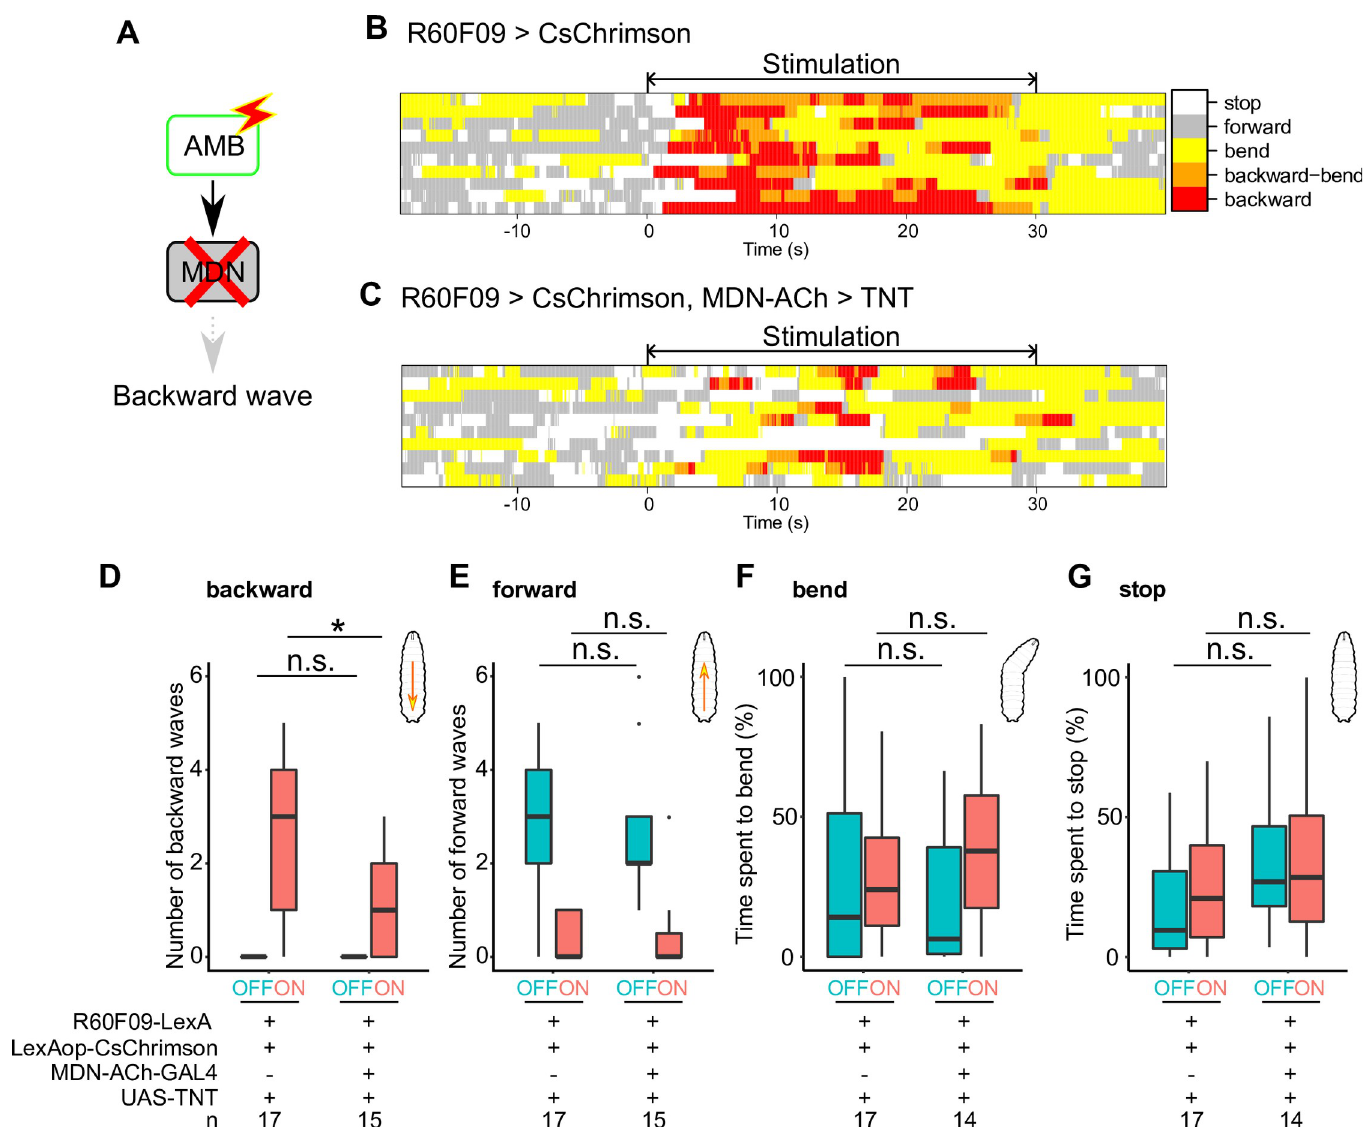
Fig 7. AMBs require MDNs to evoke backward locomotion. (A) A schematic view of optogenetic AMB activation with silencing MDNs. (B, C) Representative behavior ethograms upon optogenetic stimulation of AMB neurons. An animal expressing CsChrimson in AMBs was subjected to optogenetic activation for 30 seconds. Behavior events are color-coded: forward movement (grey), stop (white), bending (yellow), bending with backward locomotion (orange) and backward locomotion (red). Representative data from 10 different animals are shown for each genotype. (D-G) The number of backward/forward waves or percentage of time spent in a behavioral mode in 10 seconds before (OFF) and during (ON) optogenetic AMB activation with CsChrimson while silencing MDNs. In the boxplot, the width of the box represents the interquartile range. The whiskers extend to the data point which is less than 1.5 times the length of the box away from the box, and the dot represent outlier. We assessed the statistical significance by the Wilcoxon rank-sum test with the Holm method. � p < 0.05. backward responses are predominantly mediated by the gentle touch-responsive class III da (C3da) mechanosensory neurons [13]. We genetically ablated C3da neurons by expressing the pro-apoptotic genes reaper ( rpr ) and head involution defective ( hid ) [37–39] using the C3da neuron-labeling GAL4 drivers GAL4 19-12 and NompC-GAL4 [40] and found that eyelash-trig- gered backward responses were largely abolished by ablation of C3da neurons (Fig 8A; Effector control, 1 in the median, n = 15; GAL4 19-12 ablation, 0 in the median, n = 30; NompC-GAL4 ablation, 0 in the median, n = 30), but not by ablation of C4da neurons (Fig 8A; ppk-GAL4